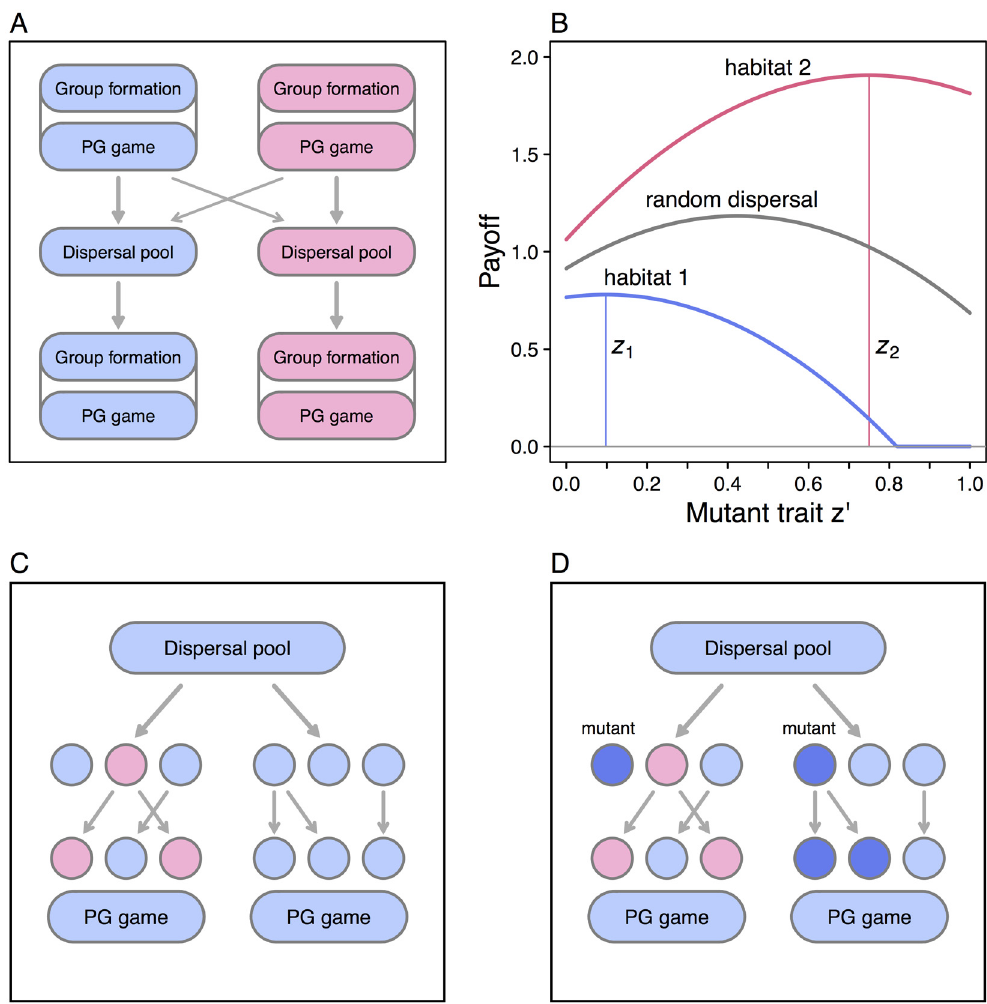
Fig 1. Elements of the model. Panel (A) shows the population cycles in habitat 1 (color coded blue) and habitat 2 (red), including formation of social groups and playing the public goods game, resulting in the production of dispersing offspring, some of which go to the dispersal pool in their birth habitat and some go the pool in the other habitat. New social groups are then formed from the pool in each habitat. (B) The expected payoff Eq (2) for mutant trait z 0 in habitat 1 (blue) and habitat 2 (red) in the limit of no between-habitat dispersal. The resident traits in habitats 1 and 2 are z 1 and z 2 (blue and red vertical lines). The gray curve shows mutant payoff when there is random dispersal, with the same two resident traits. (C) Illustration of group formation for two groups in habitat 1 with N 1 = 3. First founding group members are randomly drawn from the dispersal pool, followed by asexual reproduction forming N 1 offspring, each of which is a copy of a randomly selected parent in the founding group. (D) For a rare mutant (darker blue), founding groups with mutants will predominantly contain a single mutant. The offspring groups can contain from 0 to N 1 mutants, and in expectation contain one